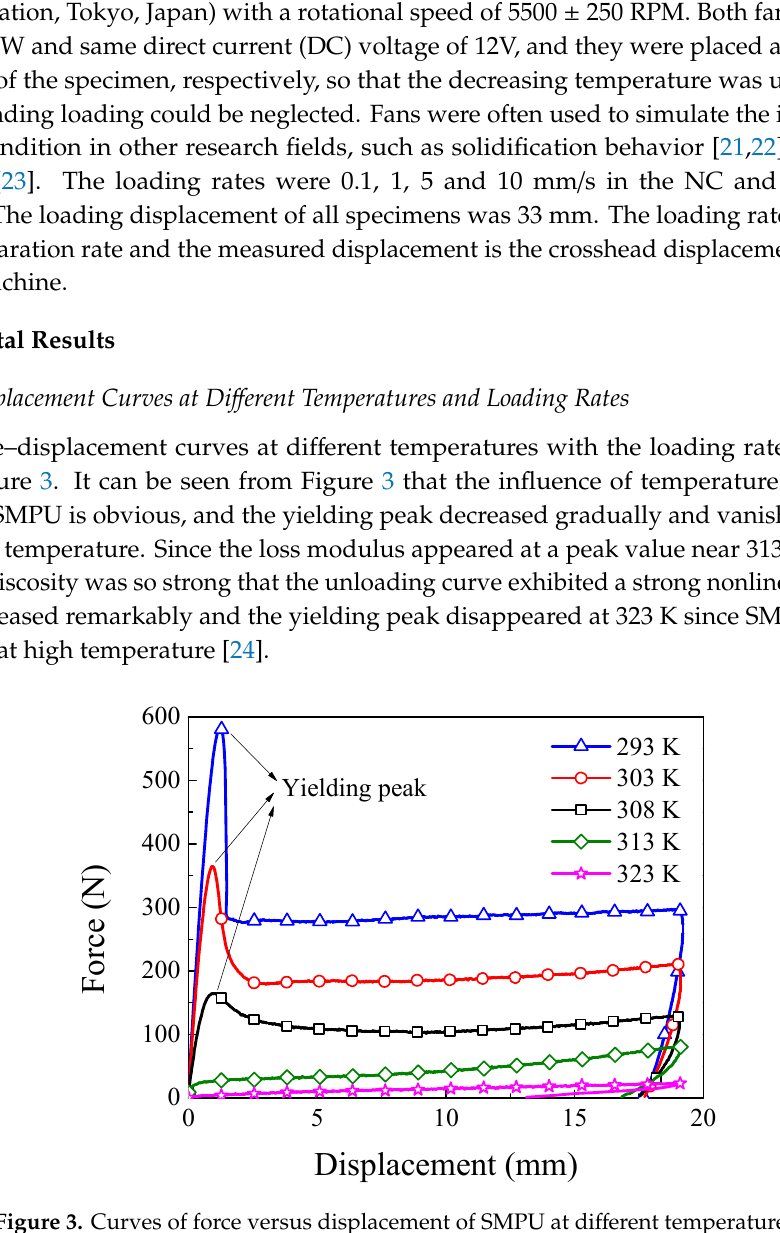
Figure 3. Curves of force versus displacement of SMPU at different temperatures.